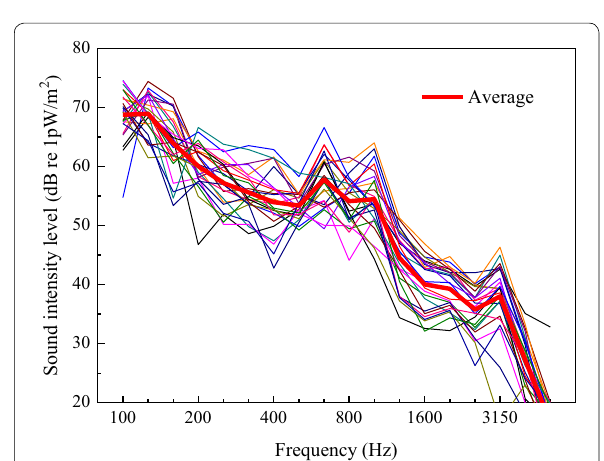
Figure 24 Sound intensity spectrum of the interior